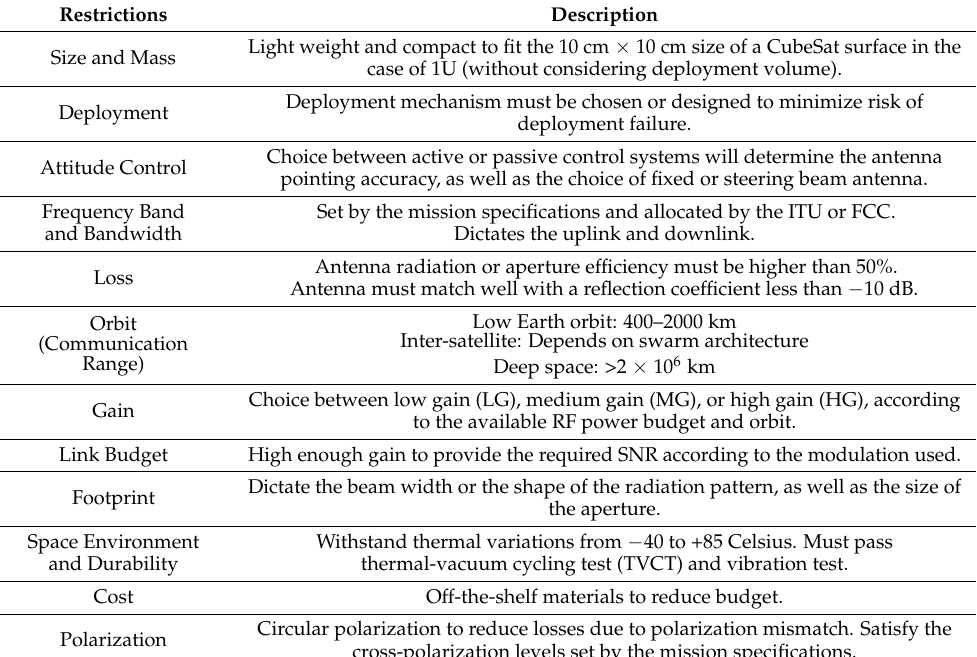
Table 2. Restrictions imposed by the CubeSat platform on antenna designs [17,39–42].